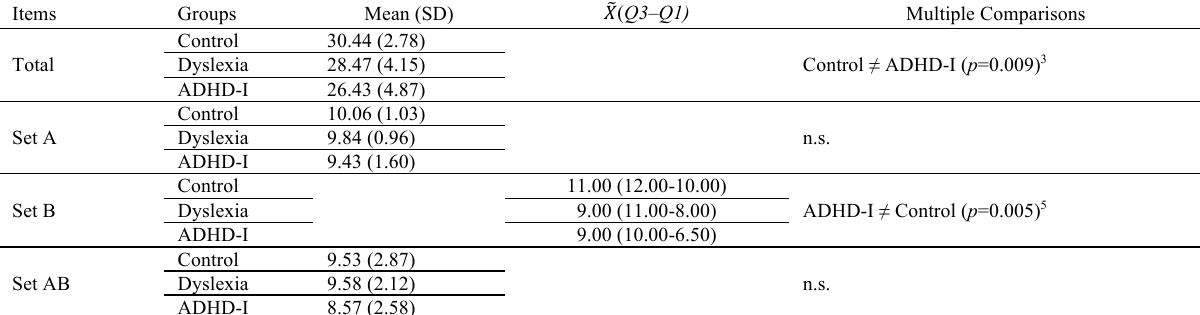
Table 12 - Means, standard deviations, median, 1 st and 3 rd percentiles, ANOVA and Kruskal-Wallis independent samples: Coloured Progressive Matri- ces